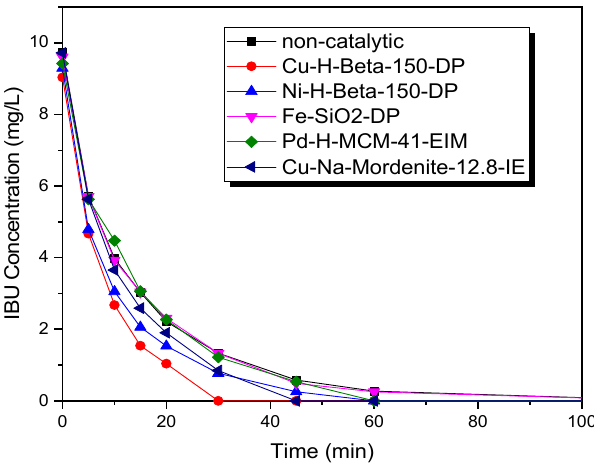
Figure 10. The degradation of IBU via catalytic ozonation in the presence of 2.5 mL/min nitrogen. [IBU] = 10 mg/L, gas flow rate = 452.5 mL/min, T = 20 °C, stirring rate = 1070 rpm.